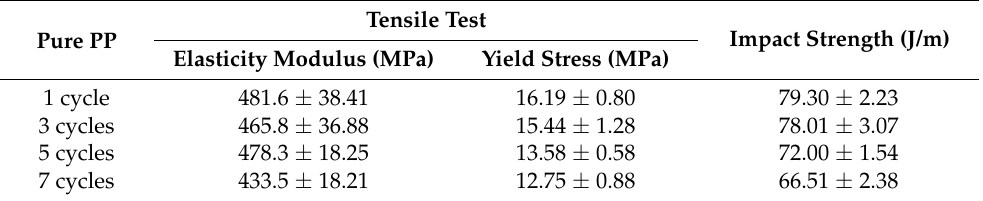
Table 2. Elastic modulus, yield stress, and impact strength of PP subjected to multiple extrusion cycles. Reproduced with permission